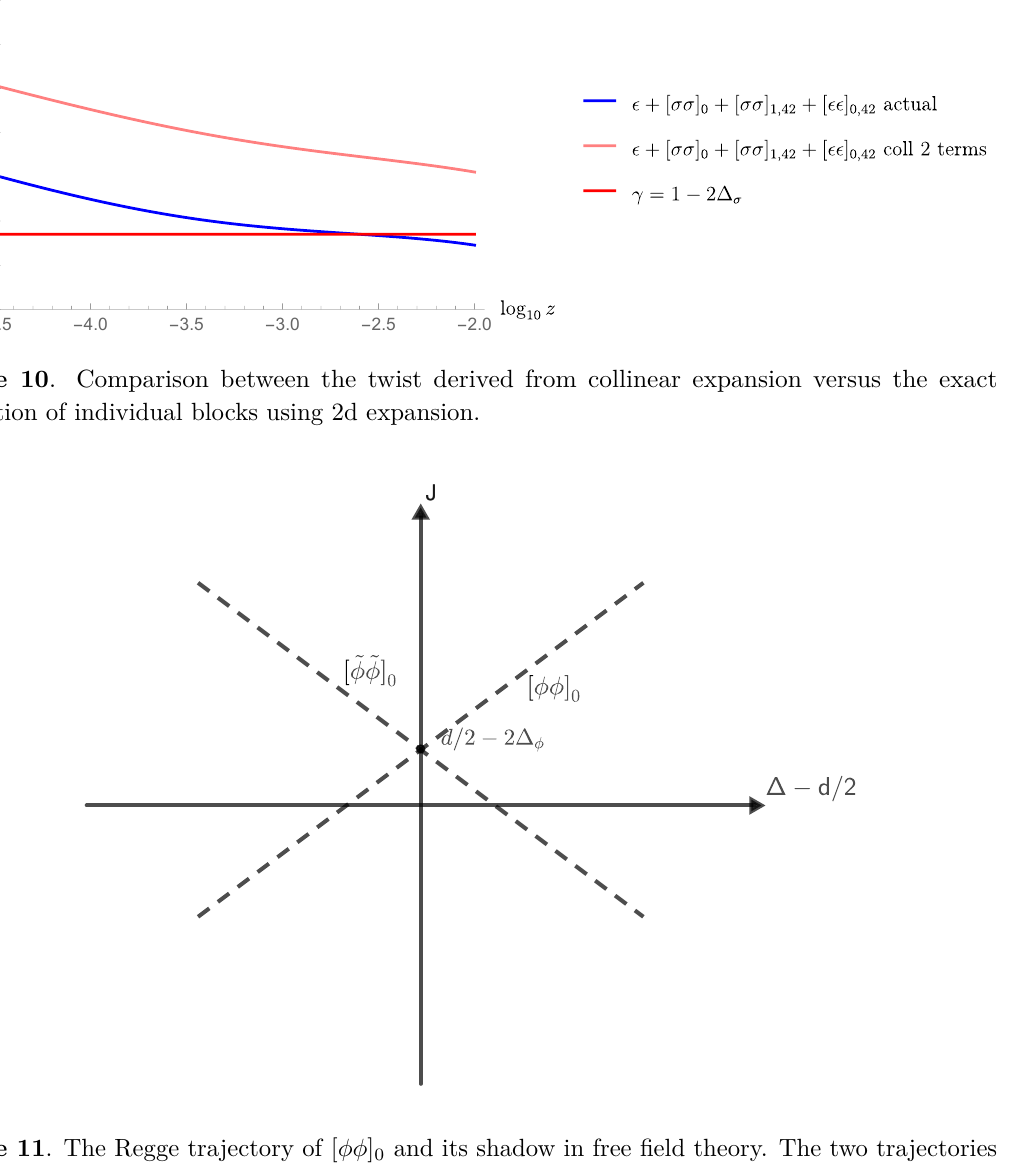
Figure 11 . The Regge trajectory of [ φφ ] 0 and its shadow in free field theory. The two trajectories intersect at the shadow symmetric